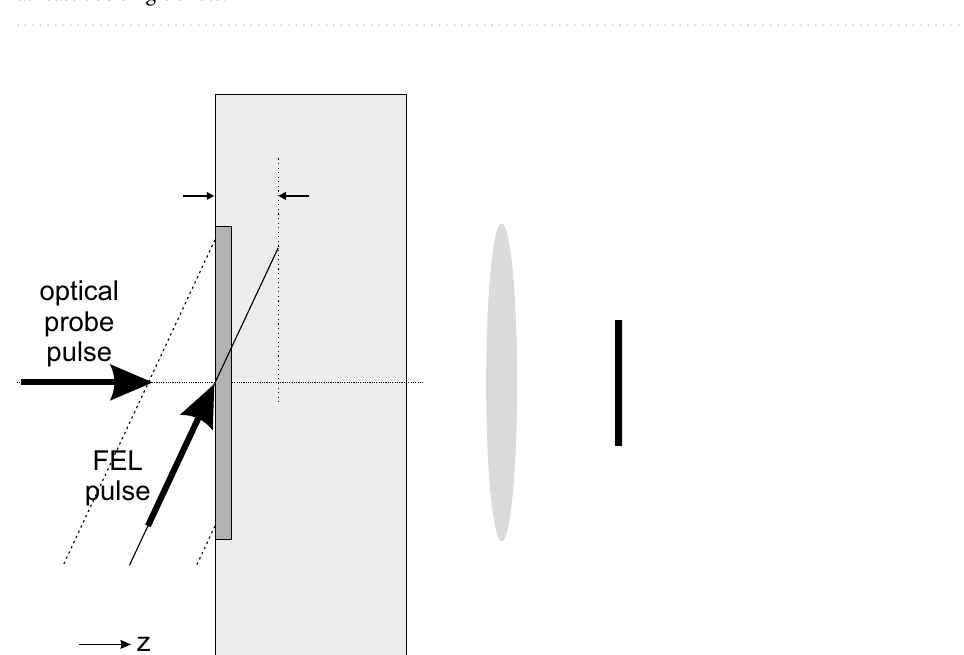
Figure 1. Normalized transmissivity, T ( t )/ T equib of XUV irradiated Si 3 N 4 recorded in the experiment performed at the FERMI facility by Finetti et al. 3 (pulse duration of 75 fs FWHM) and in our current experiment (pulse duration of 220 fs FWHM), when probed with the optical pulses of wavelength (cid:31) = 630 nm. Temporal profiles of XUV pulses are also schematically depicted. The experimental data represent averages over at least 600 single shots.